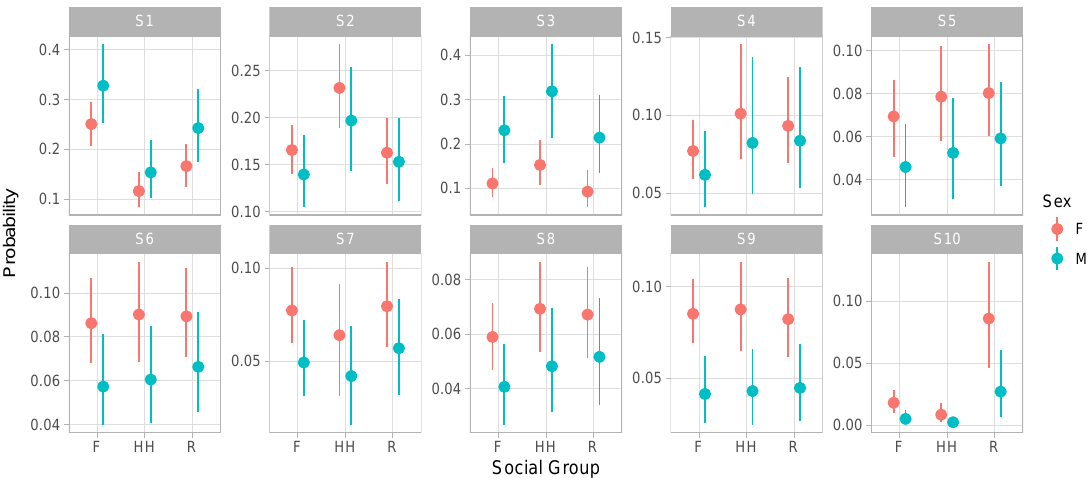
Figure 5. Expected probabilities of being in a state across different social groups for animals of average age and rank. Points represent posterior means and error bars, 95% central credible intervals of the expected